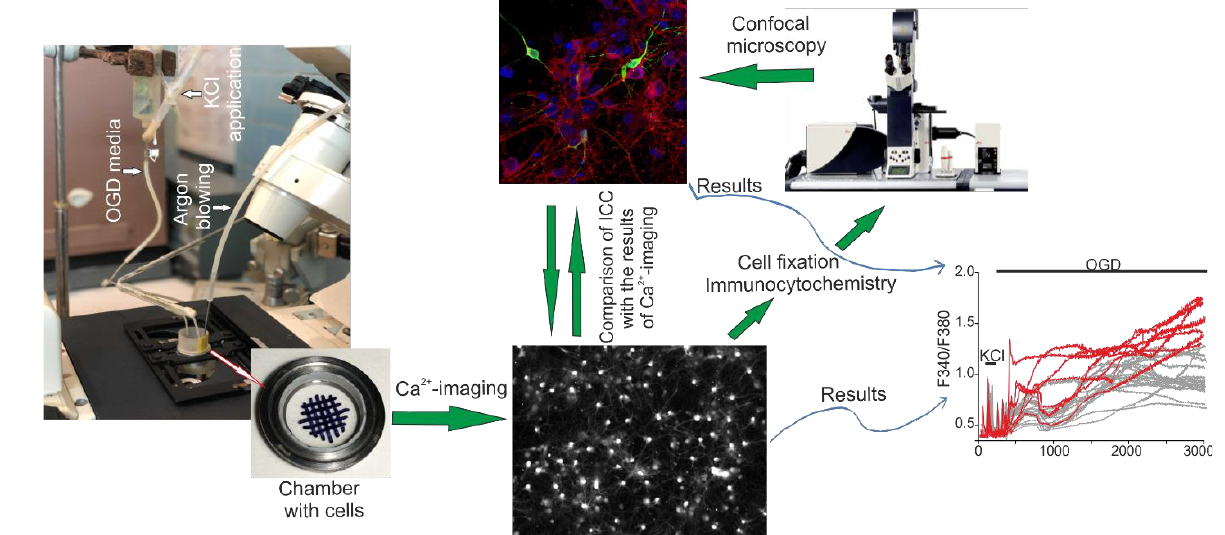
Figure 10. Scheme of the original setup for creating OGD conditions for cells of the cerebral cortex in vitro and a method for comparing the results of Ca 2+ imaging with the data of immunocytochemical staining of cell cultures. Cells of the cerebral cortex were grown on round coverslips and mounted in an experimental chamber, which was mounted on the object table of an inverted fluorescence microscope. A system for supplying OGD-media and blowing inert argon gas was connected to the chamber. After recording the [Ca 2+ ] i dynamics, the cells were fixed and stained with specific antibodies. Next, the chamber with cells was transferred to an inverted confocal microscope, and using a grid, an area with cells was found in which the change in [Ca 2+ ] i was recorded. The obtained confocal images were combined with a series of images obtained using Ca 2+ imaging. Red curves is GABAergic neurons and gray curves is non-GABA-neurons.